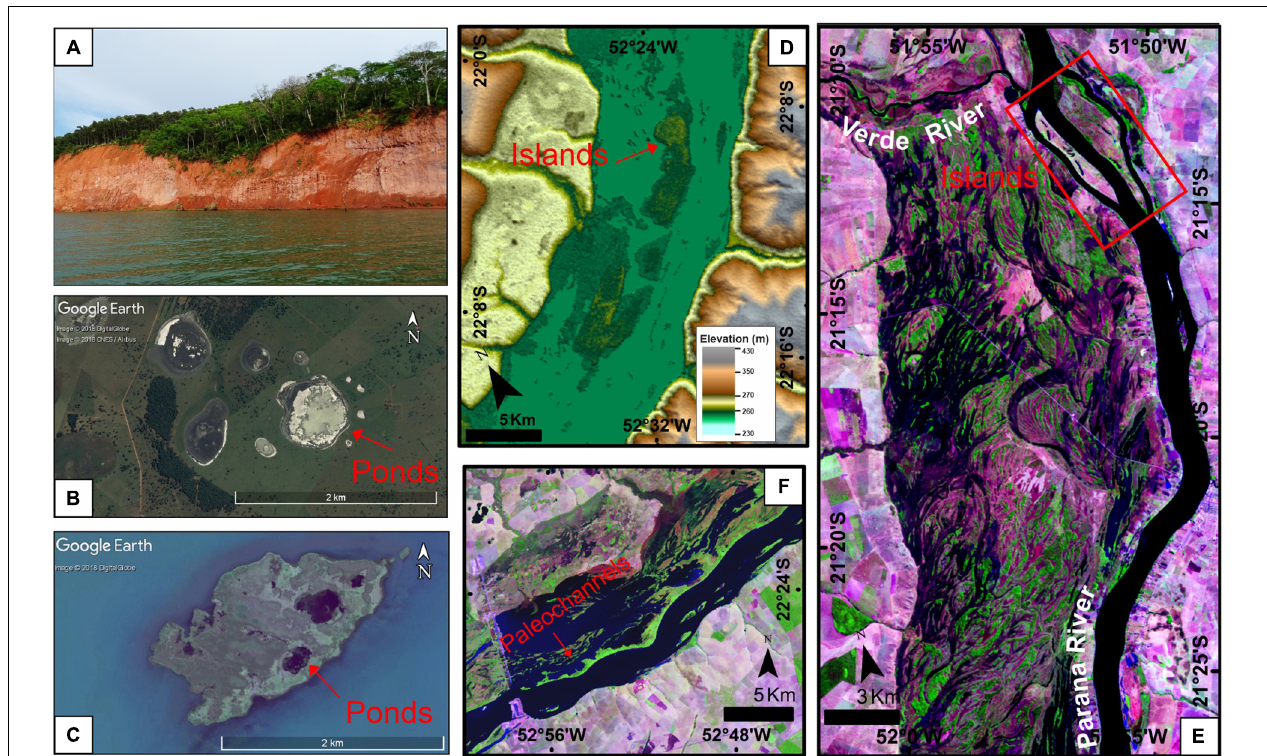
FIGURE 4 | Characteristic features of the geomorphologic units in this work. (A) Photo of the Paredão das Araras, located in the right margin of the Paraná River (Mato Grosso do Sul) between the Verde and Pardo rivers. It is a sandstone escarpment varying between 10 and 30 m in height. (B) Circular shaped ponds found in Unit 1 located ∼ 60 km upstream of Porto Primavera HPP (image acquired through Google Earth TM DigitalGlobe, 2018 and CNES/Airbus, 2018). (C) Unit 2 identified in some islands located around 52 km upstream of the Porto Primavera dam. The ponds found in Unit 2 and within the islands are different from those found in units 1 and 3, being smaller and irregular (image acquired through Google Earth TM , DigitalGlobe, 2018). (D) The islands of Unit 2 (dark green) are highlighted by the DEM. The islands are in a higher topographic position than Unit 4 (light green) and lower than Unit 1 (yellow). (E) Private Reserve of Natural Heritage (PRNH) Fazenda Cisalpina (CESP) located in Unit 3. It contains preserved geomorphological features such as paleobars and lagoons clearly associated to paleochannels with morphologies and dimensions distinct from those exhibited by the present-day channel. Highlighted in red are islands that are partially flooded. (Landsat 5 image – 1985, composition 5R4G3B). (F) More rectilinear paleochannels are observed close to the Porto Primavera HPP, parallel to the main channel, characteristic of Unit 4 (Landsat 5 image – 1985, composition